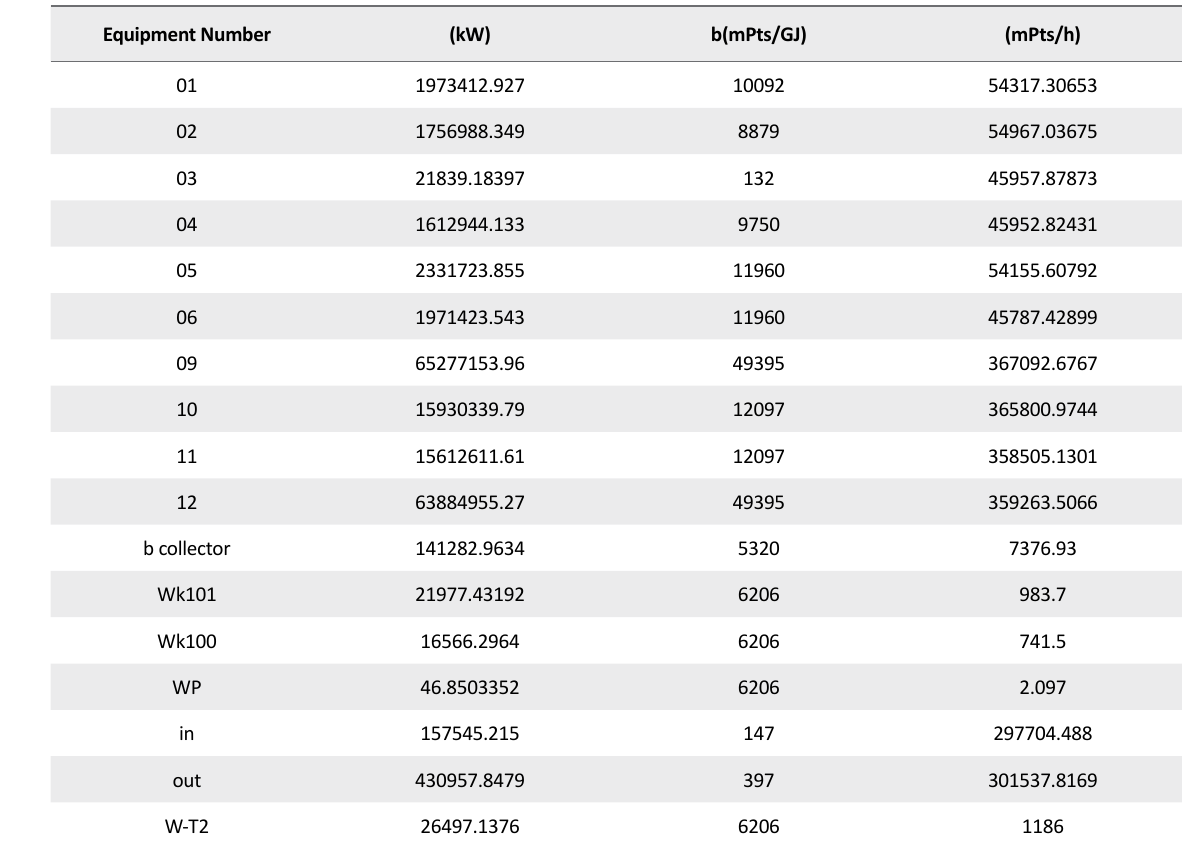
Table 11. Results of current output based on ecological